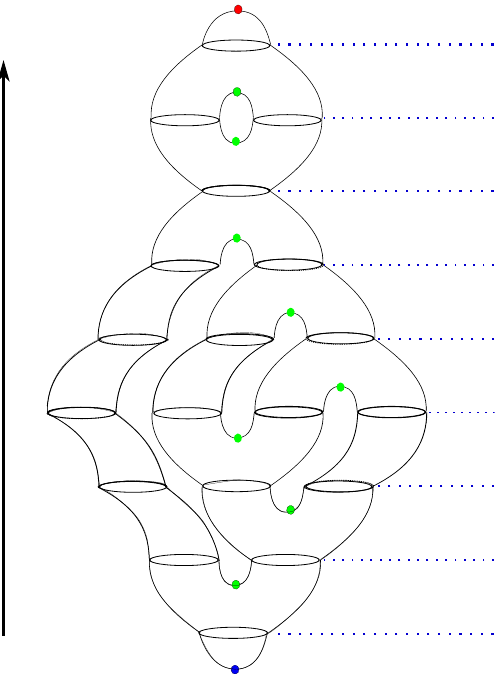
Figure 8. Given a Morse function f on a surface M , we can slice M , so that, around each critical value t , the submanifold M [ t − (cid:101) , t + (cid:101) ] is a disjoint union of simple building blocks: pair of pants, topological cylinders, and topological